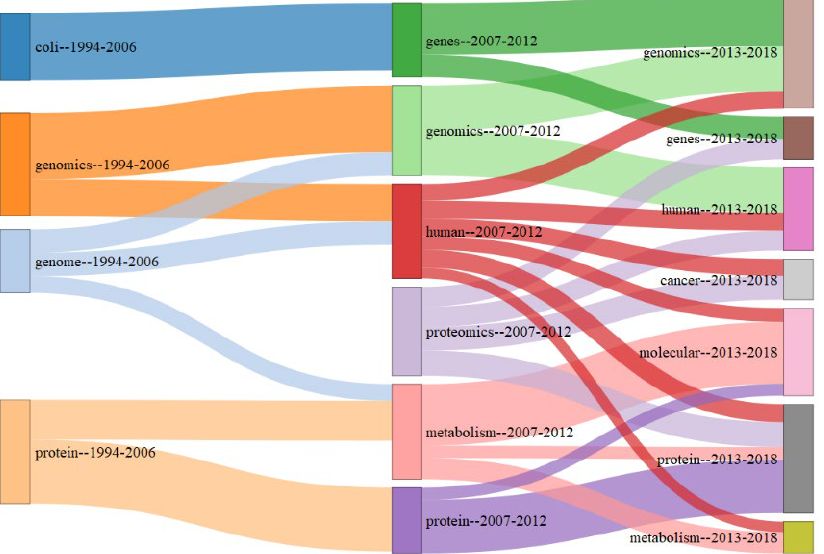
Figure 6. Thematic evolution map of Mexican bioinformatics over a 25-year window divided into three periods. The thickness of the arrows is proportional to the Inclusion index. The box area is proportional to the abundance of the theme in the literature.